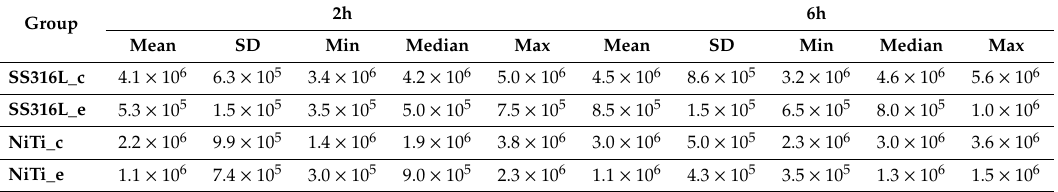
Table 2. Values of S. mutans adhesion to control an experimental surfaces at the evaluated times. Group 2h 6h Mean SD Min Median Max Mean SD Min Median Max SS316L_c 4.1 × 10 6 6.3 × 10 5 3.4 × 10 6 4.2 × 10 6 5.0 × 10 6 4.5 × 10 6 8.6 × 10